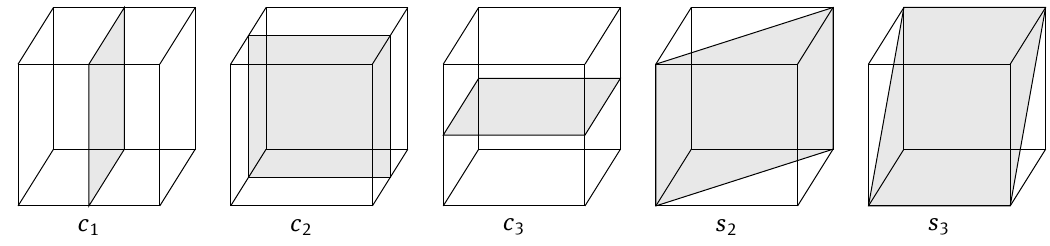
Figure 6: Generators of B 3 : complementations c 1 , c 2 , c 3 and the permutations s 2 and s 3 .